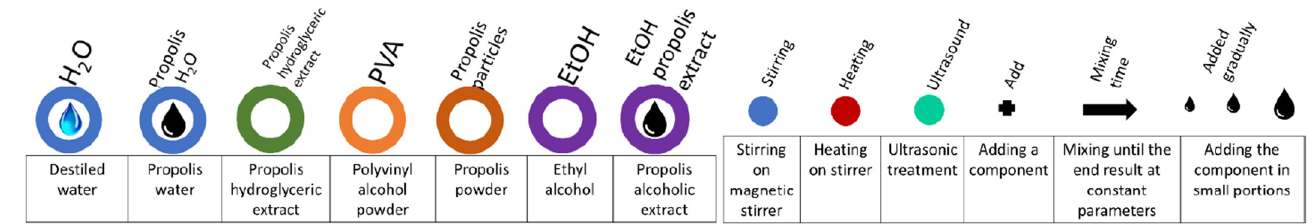
Figure 3. The components of electrospinning solutions and designations of solution-mixing process stages.